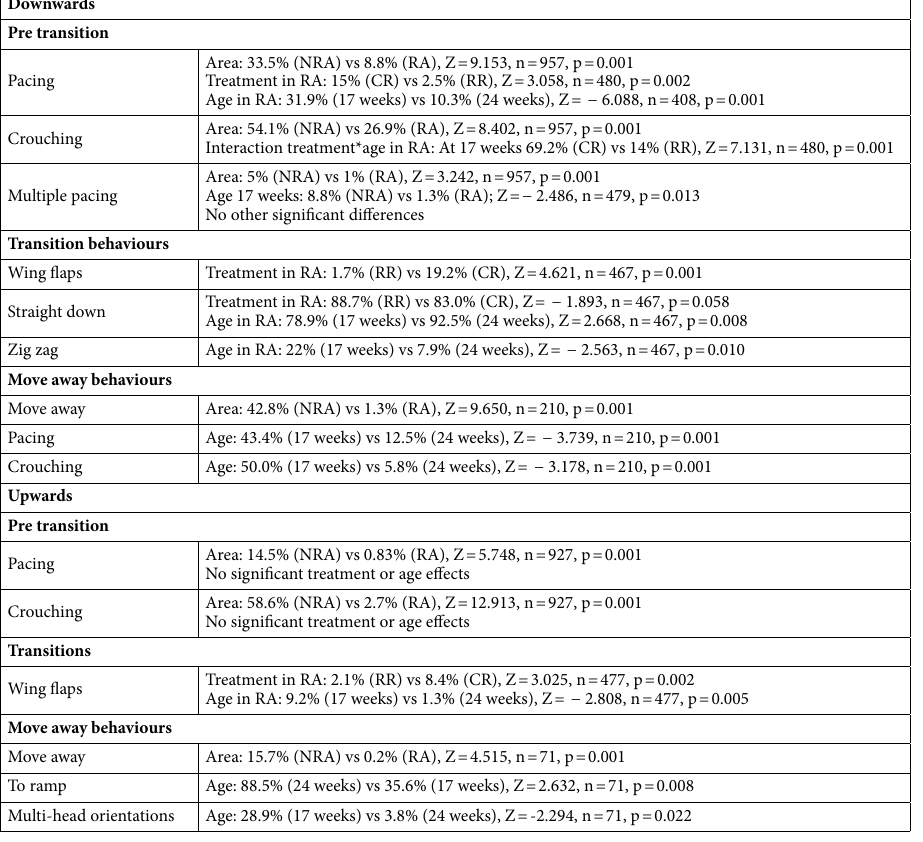
Table 3. Results for focal behaviour transitions. Separated for downwards and upwards transitions. Transition area (no ramp area = NRA and ramp area = RA) were analysed first, if a difference was found analysis was continued separately for both treatment (control reared = CR and ramp reared = RR) and age (17 weeks and 24 weeks). Only statistically significant results are